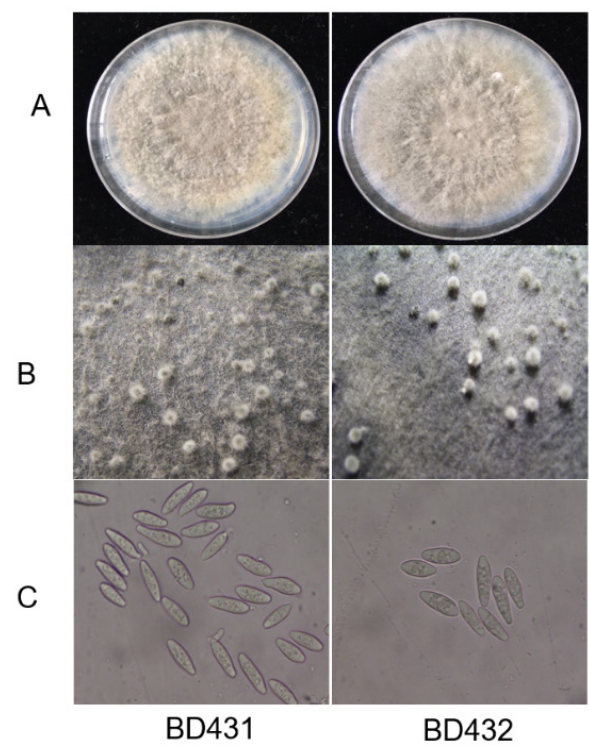
Figure 2. Morphologic characteristics of Botryosphaeria dothidea . Bd 431 comes from the diseased fruit ( left ), Bd432 comes from the wart ( right ). ( A ) The B. dothidea phenotype following a 5-day culture period on potato dextrose agar (PDA). ( B ) Pycnidia formation of B. dothidea on PDA. ( C ) Conidial morphology of B. dothidea .